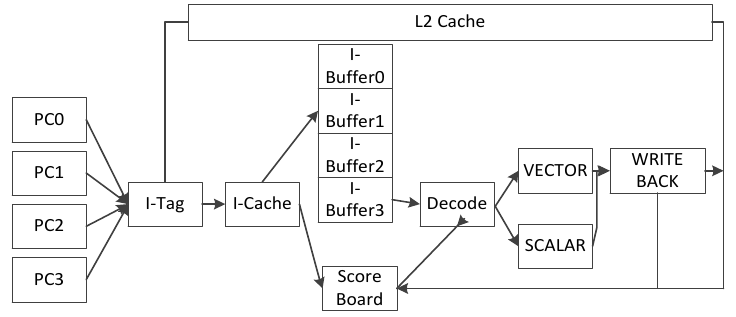
Figure 7. Nyami processor architecture.